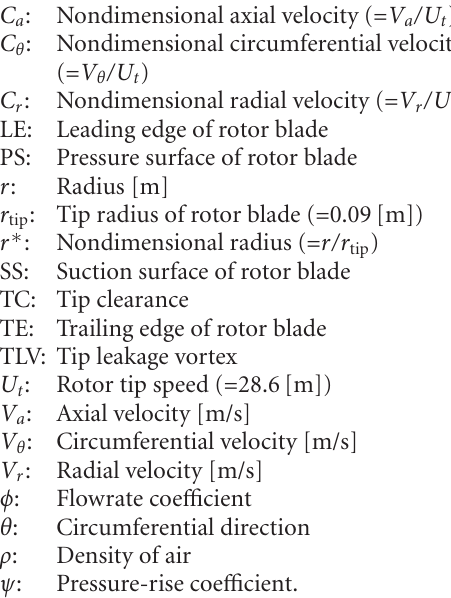
and the others are semiopened types. The e ff ect of these inlet geometries on fan characteristic and three-dimensional velocity fields at rotor outlet were discussed. The main con- clusions are as